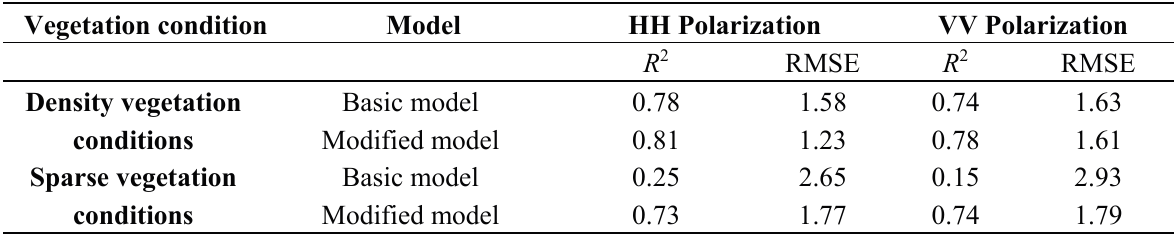
Table 2. Performance achieved on test samples using the basic model and modified